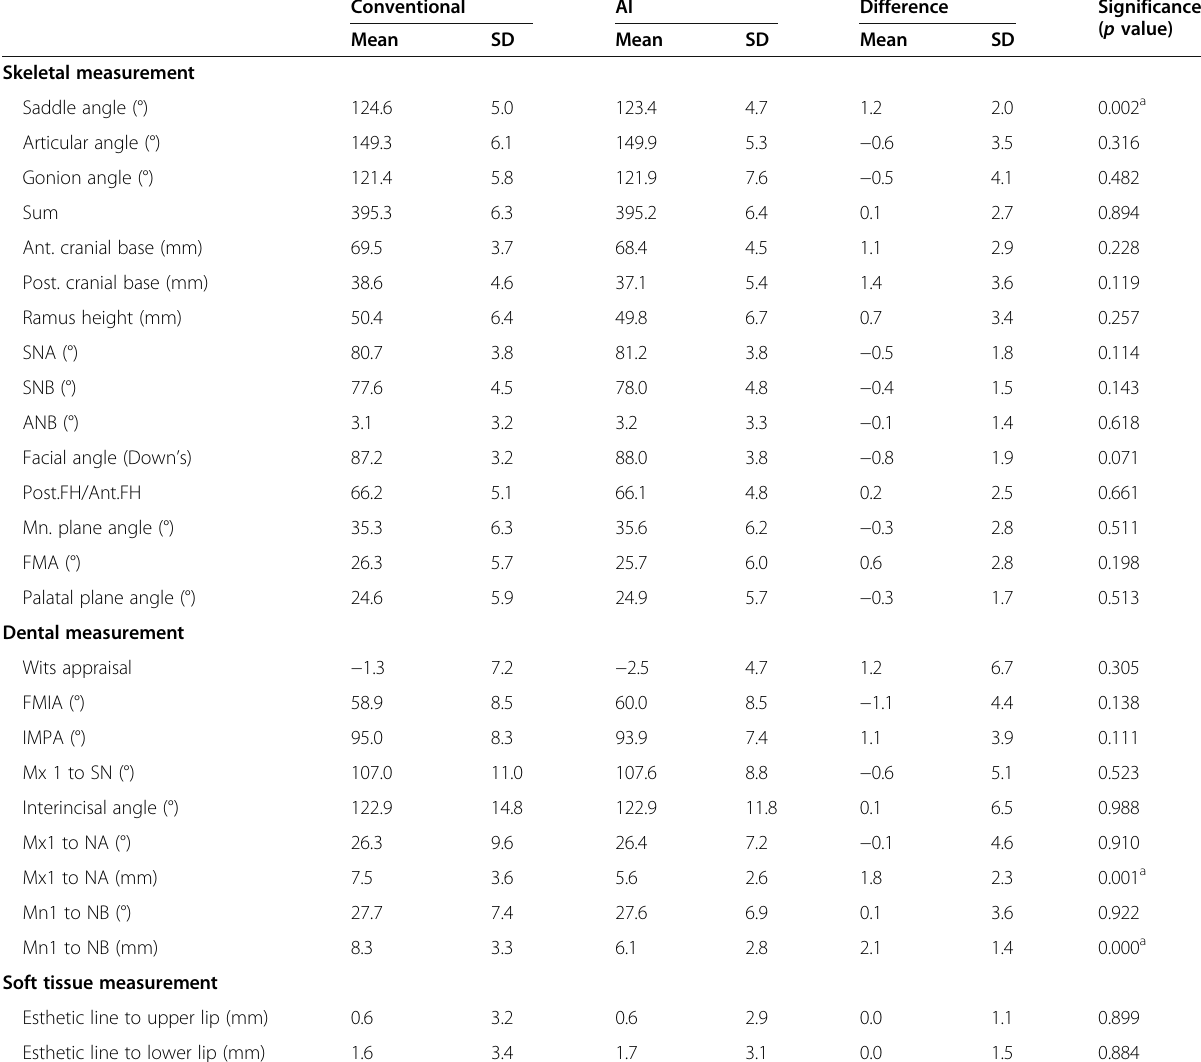
Table 2 Comparison of the cephalometric measurements between conventional and artificial intelligence methods Conventional AI